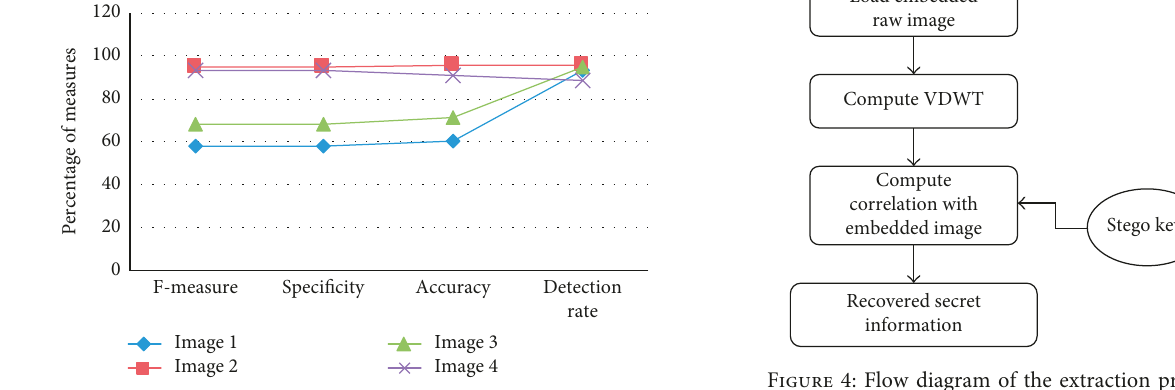
Figure 4: Flow diagram of the extraction process.